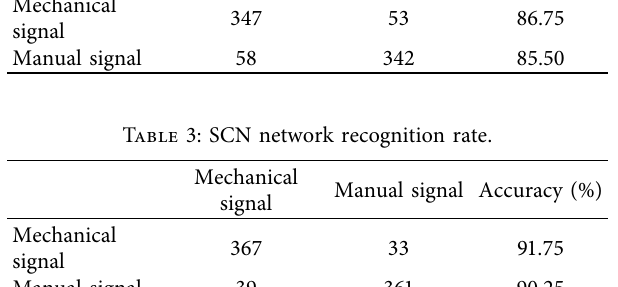
Table 2: RVFL network recognition rate. Mechanical signal